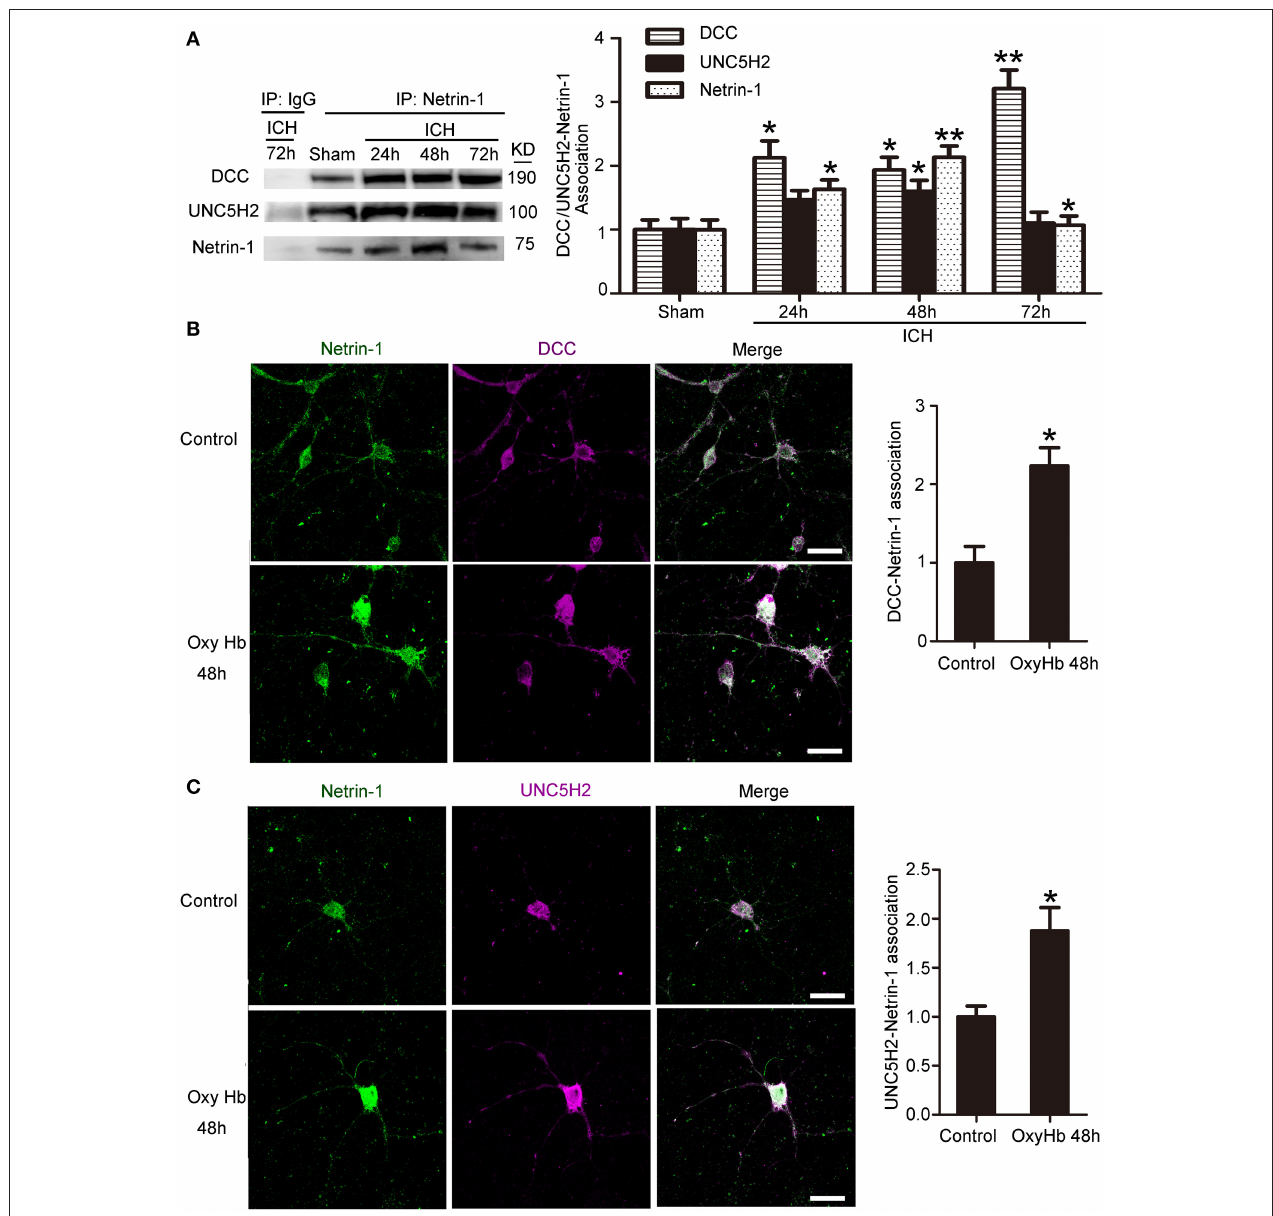
FIGURE 4 | Interactions between netrin-1 and DCC/UNC5H2 after ICH. (A) Netrin-1/DCC and netrin-1/UNC5H2 interactions in the peri-hematoma cortex were determined by a co-immunoprecipitation assay. Quantitative histogram analysis was performed. All values are expressed as mean ± SEM. The mean value of the sham group was normalized to 1.0. * p < 0.05, ** p < 0.01 vs. the sham group, n = 6. (B) Double immunofluorescence analysis was performed with netrin-1 antibody (green) and DCC antibody (purple) to observe localization and interactions. Scale bar = 20 µ m. All values are expressed as mean ± SEM. The mean value of the sham group was normalized to 1.0. * p < 0.05 vs. the control group, n = 3. (C) Double immunofluorescence analysis was performed with netrin-1 antibody (green) and UNC5H2 antibody (purple). Scale bar = 20 µ m. All values are expressed as mean ± SEM. The mean value of the sham group was normalized to 1.0. * p < 0.05 vs. the control group, n =